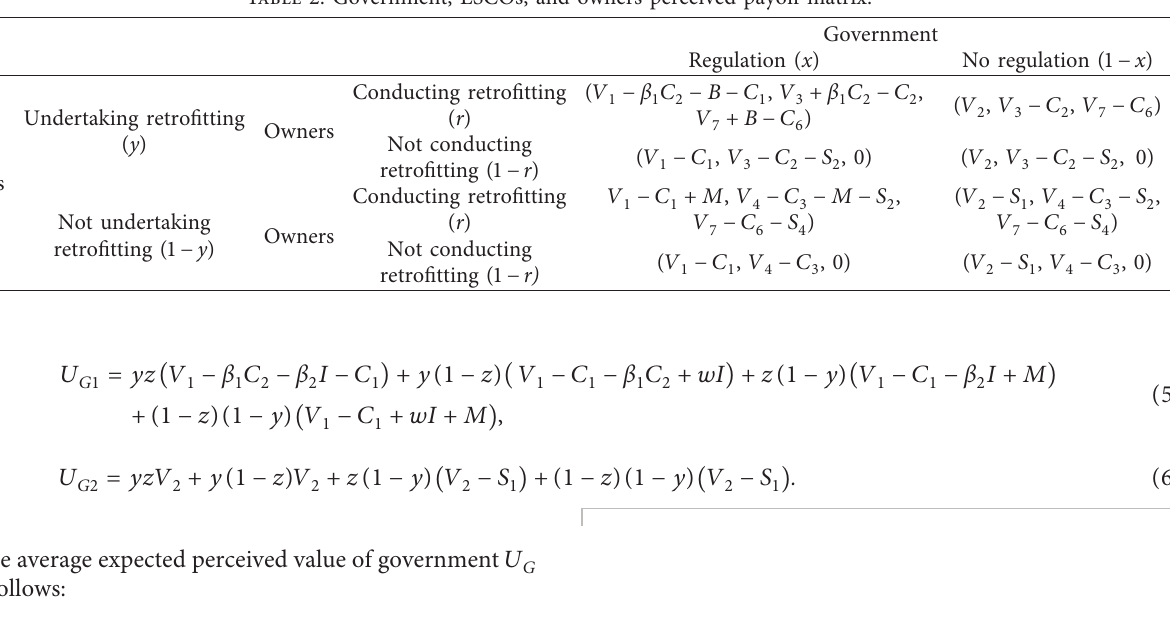
Table 2: Government, ESCOs, and owners perceived payoff